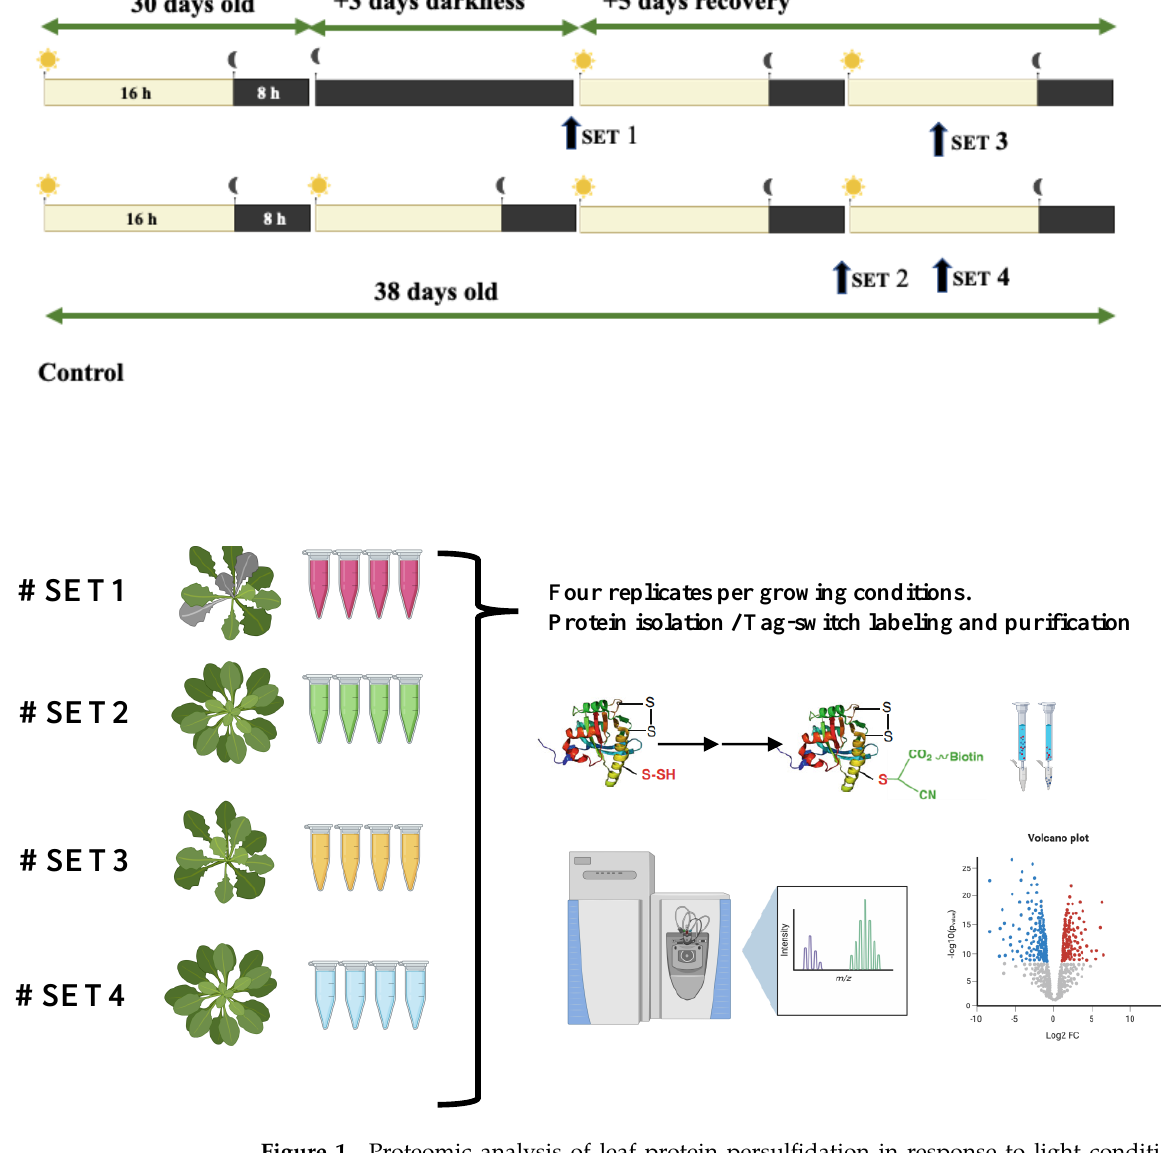
Figure 1. Proteomic analysis of leaf protein persulfidation in response to light conditions and carbon starvation. Workflow of leaf sample preparation followed by tag-switch protein labeling, persulfidated protein purification, tryptic digestion, and quantitative Data-independent acquisition (DIA) analysis of eluted